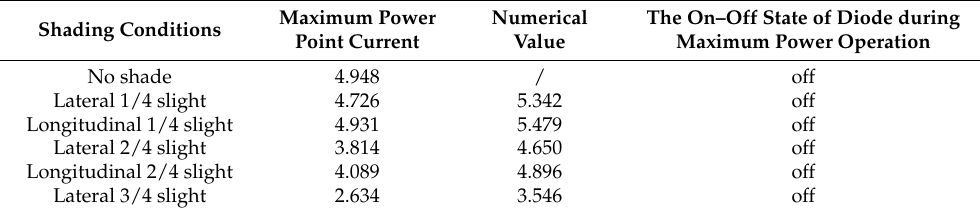
Table 7. The bypass diode on–off state in each shading